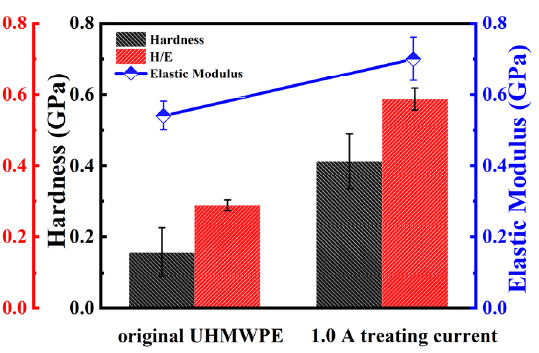
Figure 9. The hardness, elastic modulus, and H/E of the original UHMWPE and UHMWPE sub- strate treated with carbon plasma of 1.0 A.